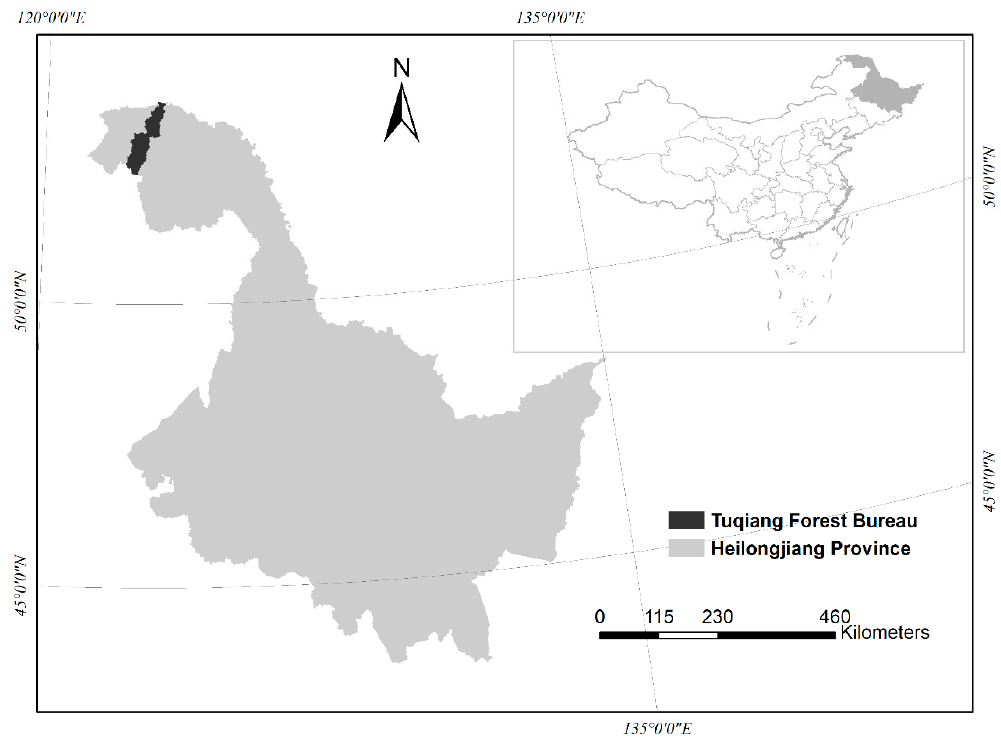
Figure 1. Location of the Tuqiang Forest Bureau study site in Heilongjiang province, China.